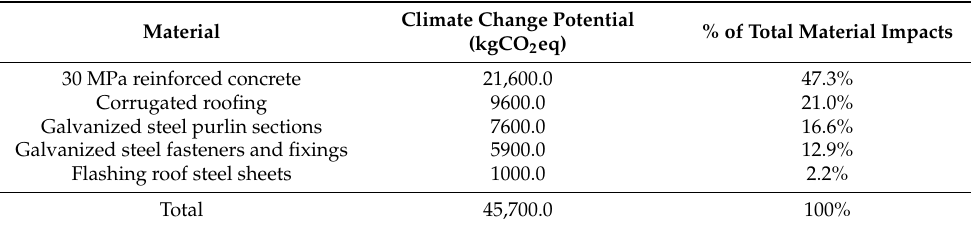
Table 2. Climate change potential by the absolute quantity of each material present.